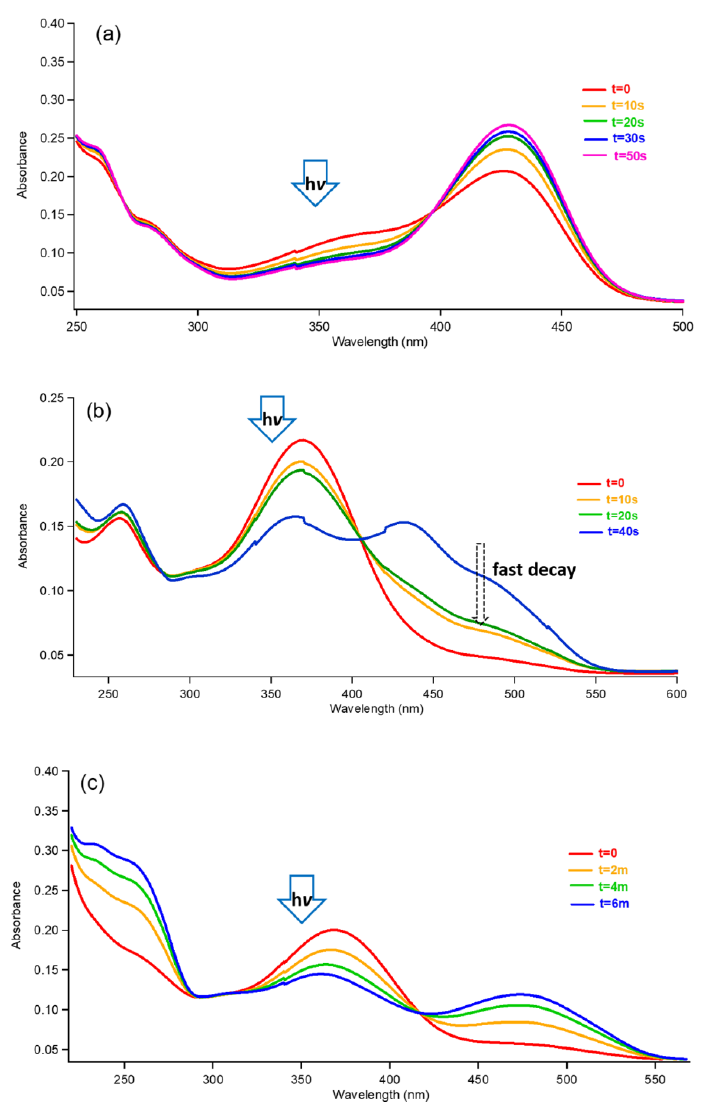
Figure 6. Irradiation of F2 solutions ( a ) 350 nm at pH = 3.1; ( b ) 350 nm at pH = 4.2; ( c ) 350 nm at pH = 5.6.